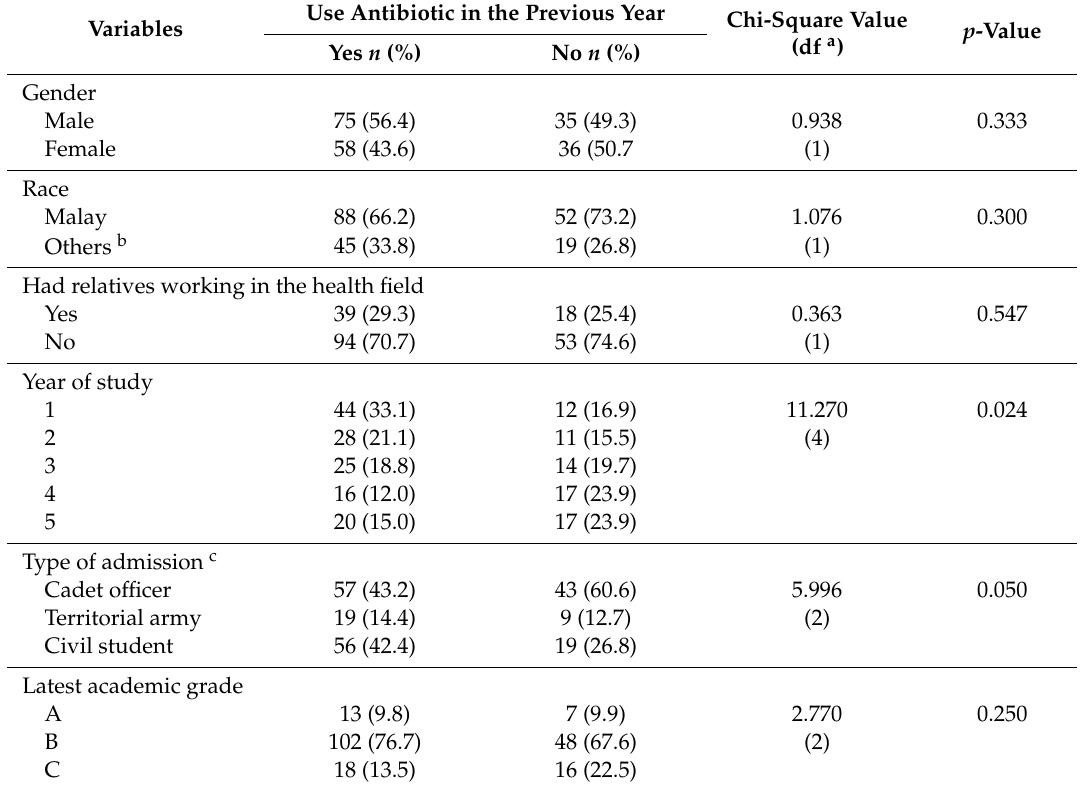
Table 5. Chi-square test on factors associated with the usage of antibiotics ( n =